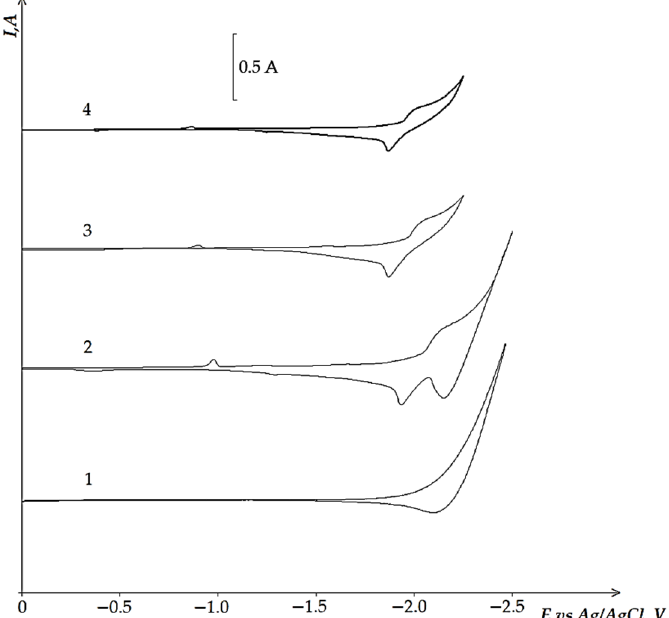
Figure 1. Cyclic voltammograms of the KCl-NaCl-NdCl 3 melt on the tungsten electrode at 973 K and at different polarization rates: curves 1 and 2–0.2 V/s; curve 3–0.1 V/s; curve 4–0.05 V/s. Concentration of NdCl 3 : curve 1–0 mol/cm 3 ; curves 2, 3, 4–4.0 × 10 − 4 mol/cm 3 . A square of the cathode is 0.42 cm 2 .